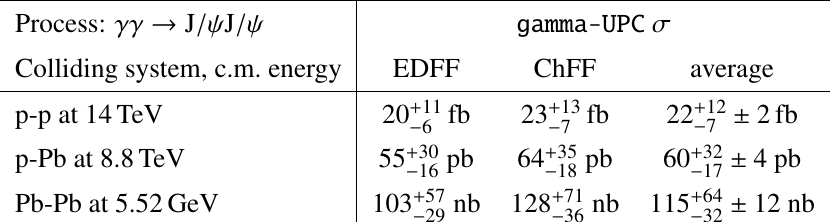
Table 6 . Total cross sections for (cid:13)(cid:13) ! J = J = in UPCs at the LHC, computed with EDFF and ChFF (cid:13) fluxes and their average. The quoted asymmetric uncertainty is derived from the renormalization scale variation. dielectron and dimuon J = decay channels in ALICE (although the actual measurable yields should be smaller taking into account detector acceptance and e (cid:14)